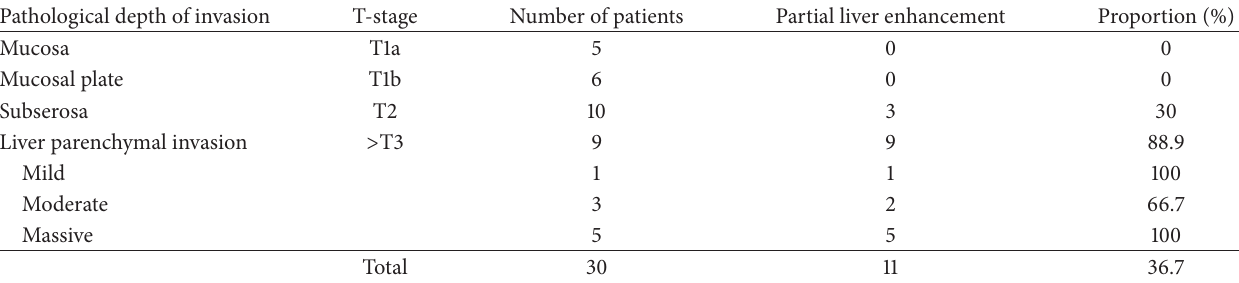
Table 3: Partial liver enhancement and pathological depth of cancer.